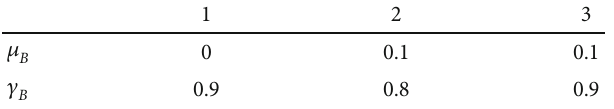
Table 28: Intuitionistic fuzzy set B .